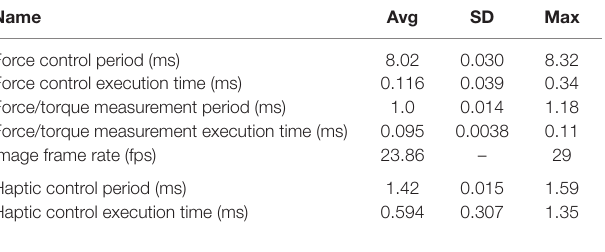
TaBle 2 | real-time performance statistics.